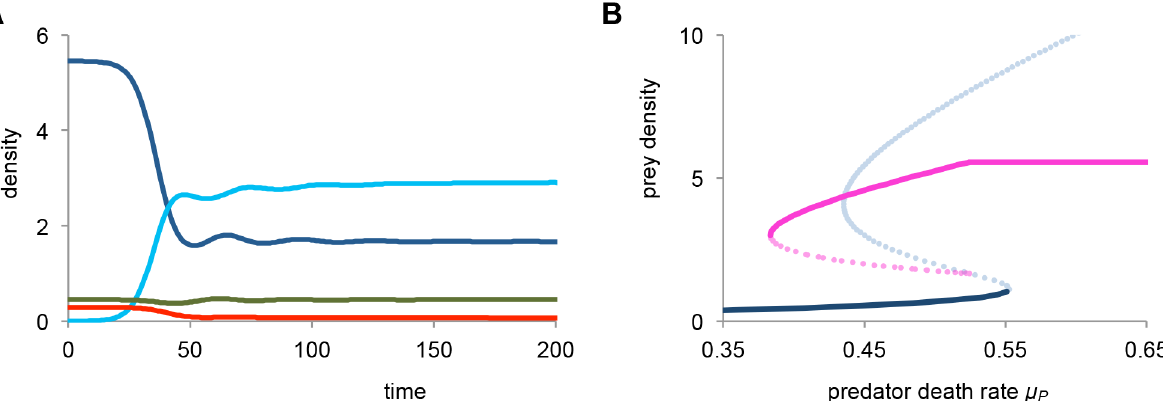
Fig 2. The disease can suppress the predator and enhance bistability and population stuntedness. (a) Dynamics after introduction of the disease in the stunted population state for μ P . = 0.45. Density of infected juveniles J I are shown in light blue. Disease parameters are β = 0.06, α = 0.05, and δ = 1, indicating that sick individuals have full competitive ability. For other colors and parameters see Fig 1. Note the strong reduction in predator density after introduction of the disease. (b) Bifurcation diagram for total juvenile prey density (i.c. J S +J I ) as a function of predator death rate μ P . The solid blue line indicates the stable disease free state, and the solid purple line denotes the endemic state. Dashed lines indicate unstable equilibriums. Note that the introduction of the disease considerably increases the region of bistability.